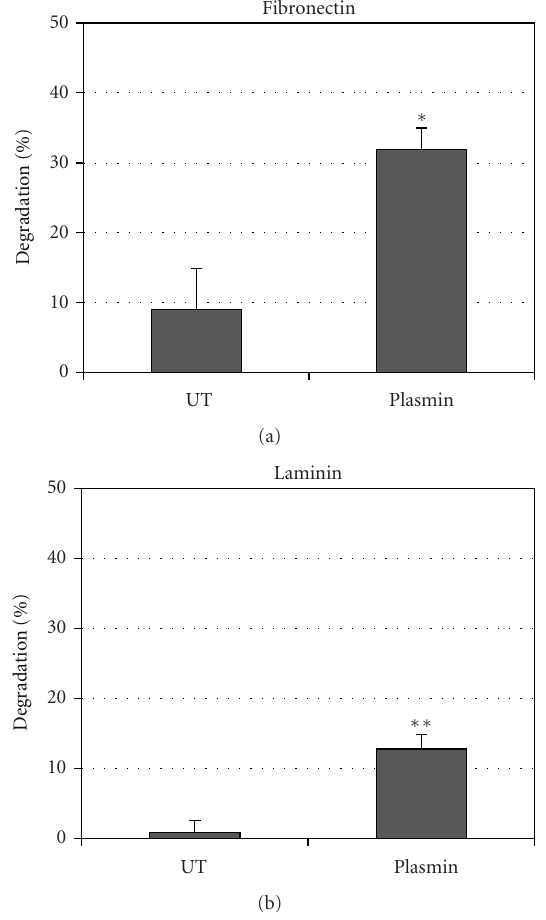
Figure 5: Fibronectin and laminin degradation by plasmin-coated leptospires. Spirochetes were incubated in lsPBS with no additions (UT) and with addition of PLG and uPA (plasmin). ELISA plate wells coated with 0.5 μ g/well fibronectin (a) or laminin (b) were incubated for 20 h with the spirochetes from each experimental group to allow substrate digestion. Plates were then incubated with antibodies antilaminin or antifibronectin. A reduction in absorbance was interpreted as substrate digestion, relative to controls lacking bacteria (0.5 μ g/well purified laminin or cellular fibronectin, corresponding to 0% degradation). Percent degrada- tion (a reduction in absorbance value relative to control lacking bacteria) was calculated as described in Section 2. Bars represent mean percent substrate degradation relative to the positive control (0% degradation) ± the standard deviation of three replicates. The experiment was independently performed three times with similar results. P < 0.001 ( ∗ ) and P < 0.01 ( ∗∗